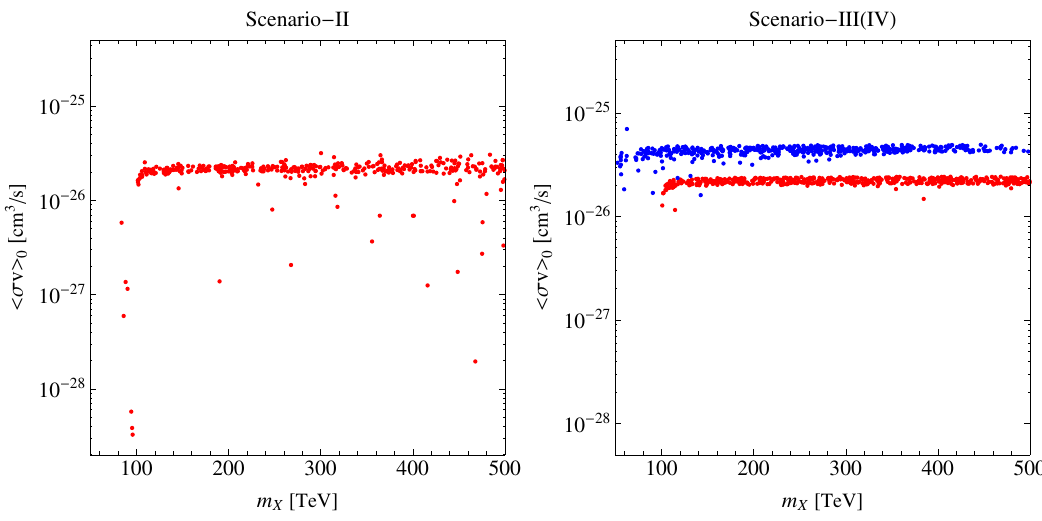
Figure 6 . Left: the current DM annihilation cross section in Scenario-II as a function of m X . Right: that for Scenario-III and IV represented by red and blue